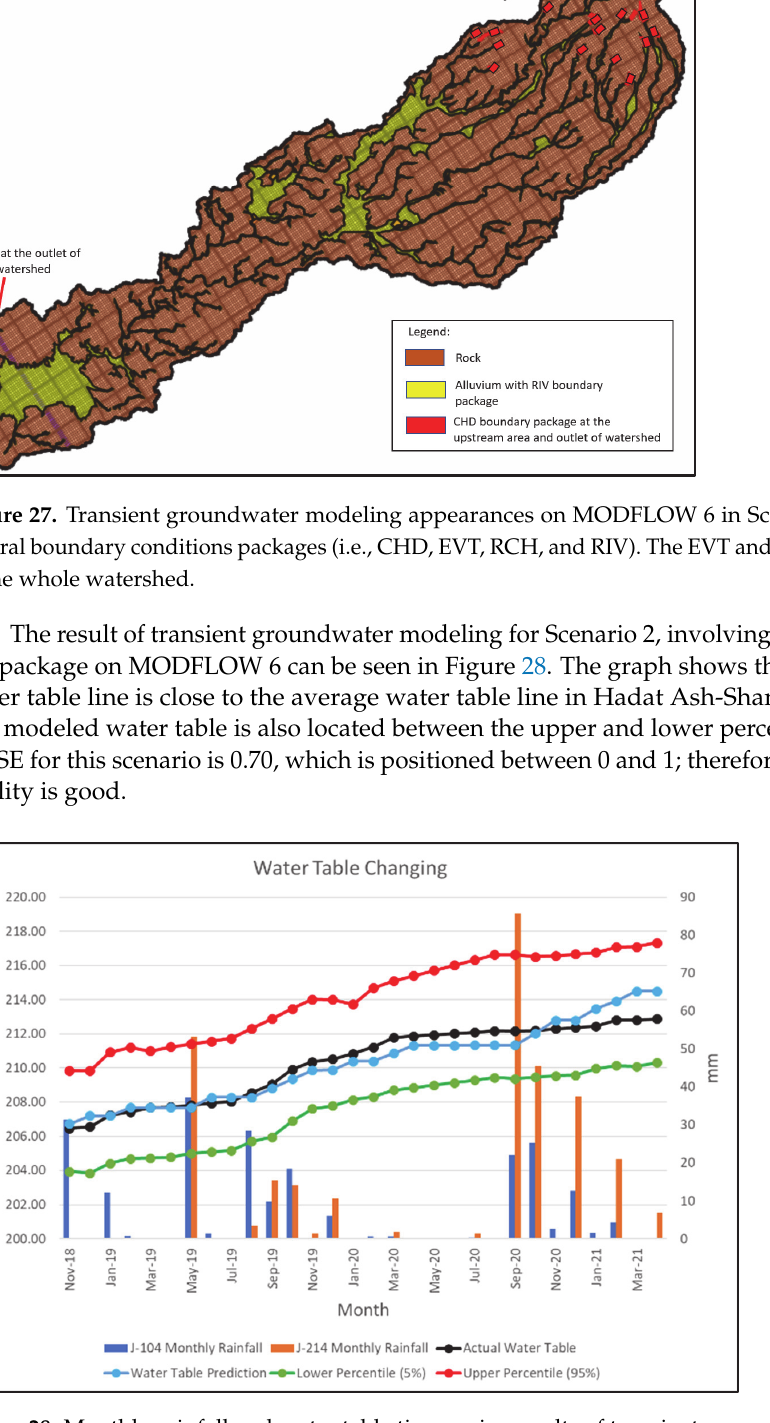
Figure 28. Monthly rainfall and water table time-series results of transient groundwater modeling for Scenario 2 (discharge from the ephemeral stream in Al ‐ Lusub watershed). The yearly water balance for the entire system in the Al ‐ Lusub watershed, based on Scenario 2, is shown in Table 10. The cumulative water input and output for year 2019 are 105,402,119 m 3 and 105,378,735 m 3 , while for 2020 are 127,549,634 m 3 and 127,525,717 m 3 , respectively. The percent discrepancy for both years is 0.02% or close to zero, which means that the model has good conservation of mass, and the error is minimum. Table 10. Yearly water balance for transient groundwater modeling Scenario 2.